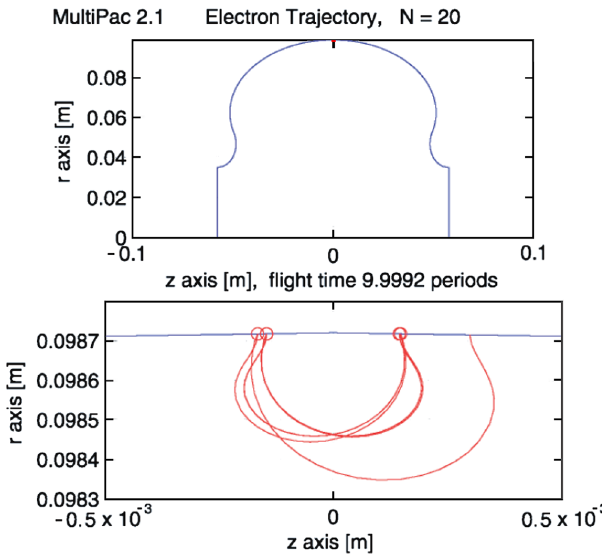
FIG. 1. Resonant electron orbits at a peak surface field level about 37 MV = m